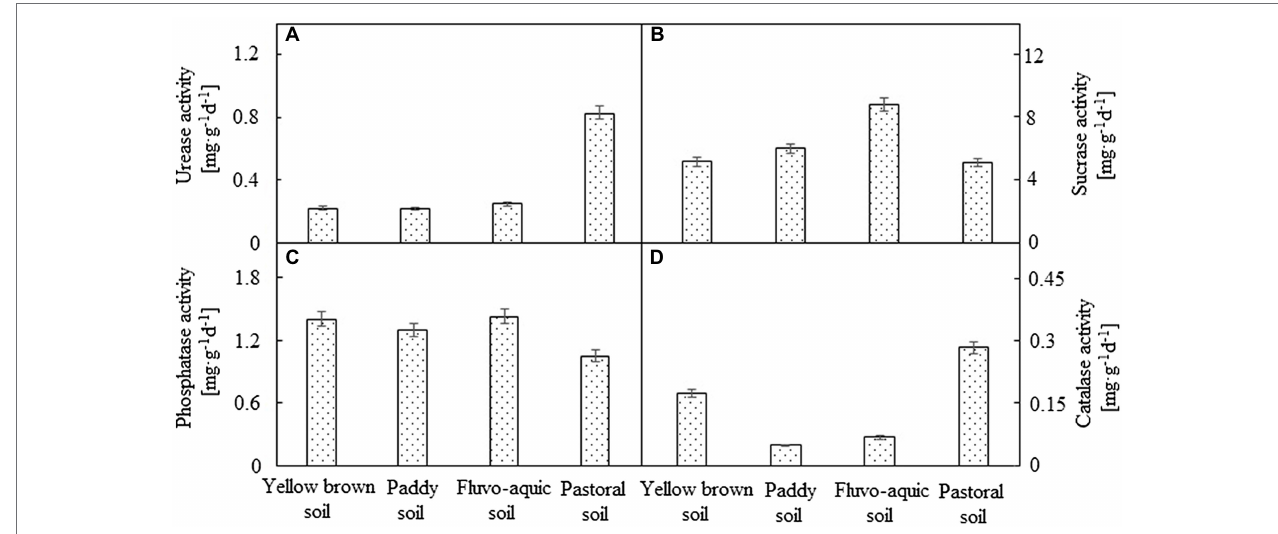
FIGURE 1 | The enzyme activities of different soils. (A–D) represented urease, sucrase, phosphatase and catalase activity, respectively.